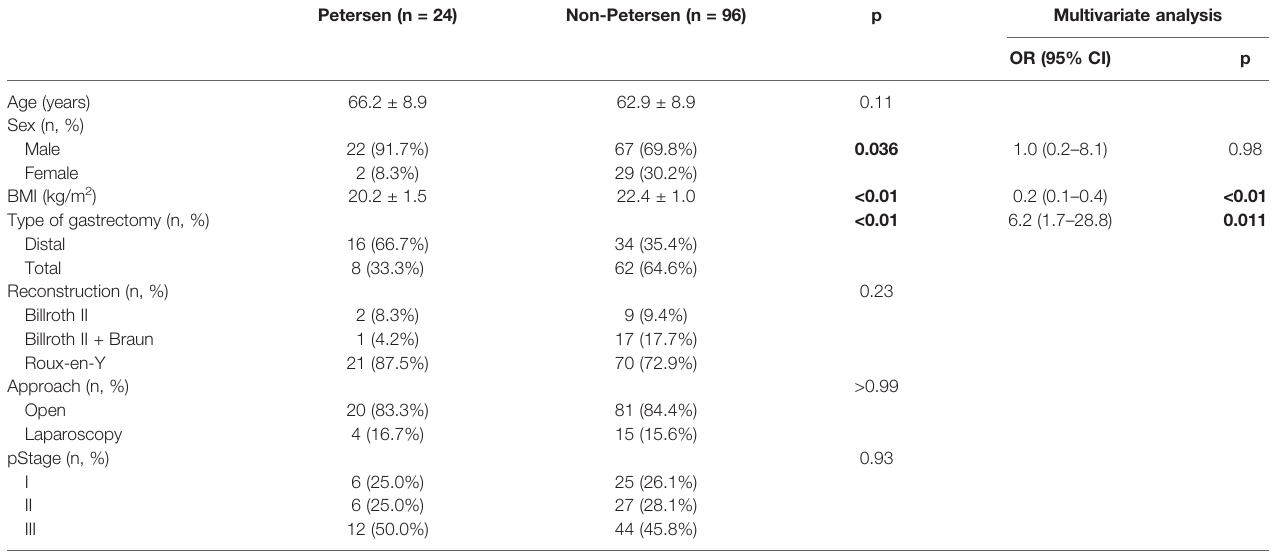
BMI, body mass index. Bold values indicate statistical signi fi